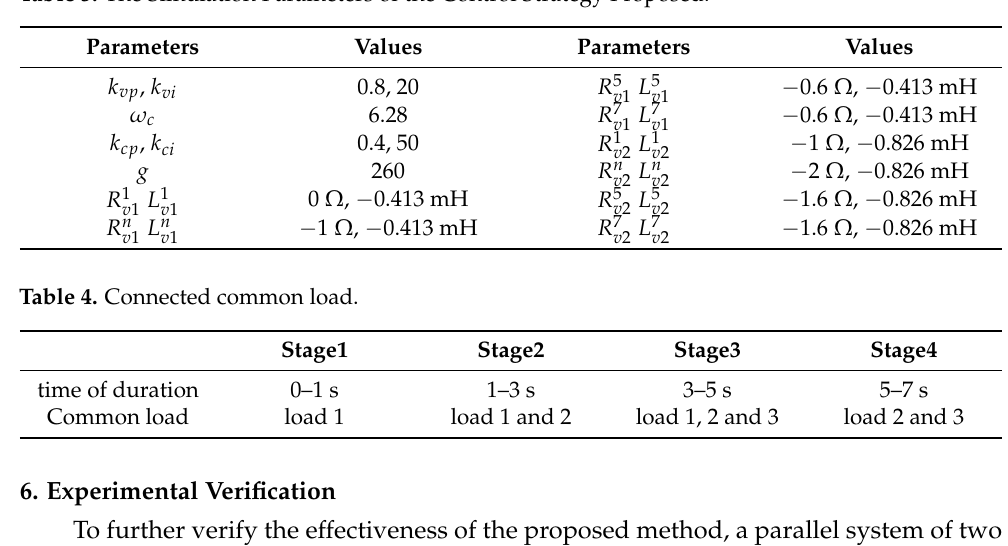
Table 3. The Simulation Parameters of the Control Strategy Proposed.